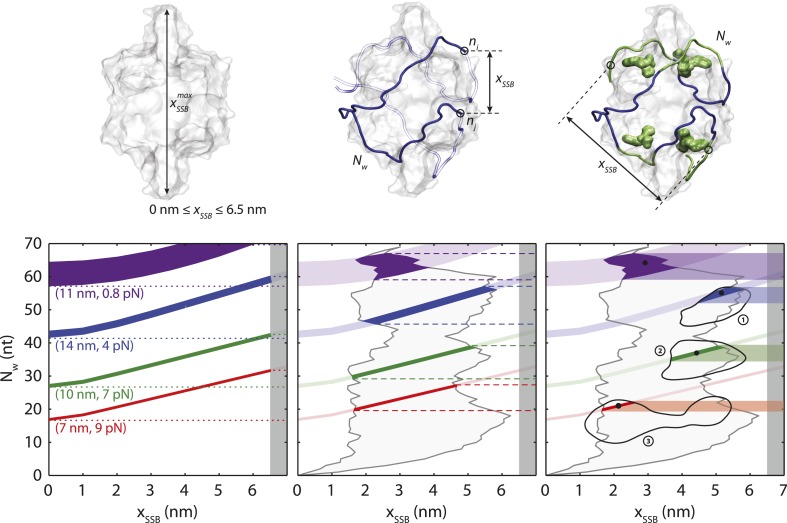
SSB wrapping models.Three-level modeling of SSB wrapping configurations. Schematics of SSB, wrapped ssDNA (blue), and the distance between wrapped ends, xSSB (black arrow; top panels). Each extension change data point Δx(F) in Figure 3A corresponds to a curve in the space of possible Nw and xSSB, according to Equation 5 (colored curves, bottom panels). The widths of the curves correspond to the error bars in Figure 3A. Selected data points from Figure 3A are displayed (purple: F = 0.8 pN, Δx = 11 nm, blue: 4 pN, 14 nm, green: 7 pN, 10 nm, and red: 9 pN, 7 nm). At the first level of modeling (left panels), xSSB is assumed to be limited only by the size of the protein (i.e., xSSB < 6.5 nm; dark gray shaded area). The range of possible Nw corresponding to each selected data point is shown by the colored dotted lines. At the second level (middle), the range of possible xSSB is refined by utilizing the (SSB)65 crystal structure. The end-to-end distance between every pair of nucleotides ni and nj along the ssDNA in the structural model defines a lower and upper bound of xSSB for each Nw (gray shaded area). This, in turn, narrows down the range of possible Nw for each data point (colored dashed lines). At the third level (right), four ‘hotspots’, residues on each SSB monomer with which nucleotides interact most strongly (green molecular surfaces in the schematic and green nucleotides), are used to refine the estimates for xSSB further. Three regions near the hotspots (black contours) are identified and used to calculate xSSB. The numbering (1, 2, and 3) corresponds to the configurations shown in Figure 3—figure supplement 2. This analysis provides the narrowest estimate for the range of Nw for each data point Δx (colored bands). The best estimates for Nw are obtained from the center of this range (black dots); these are plotted in Figure 3C vs force.